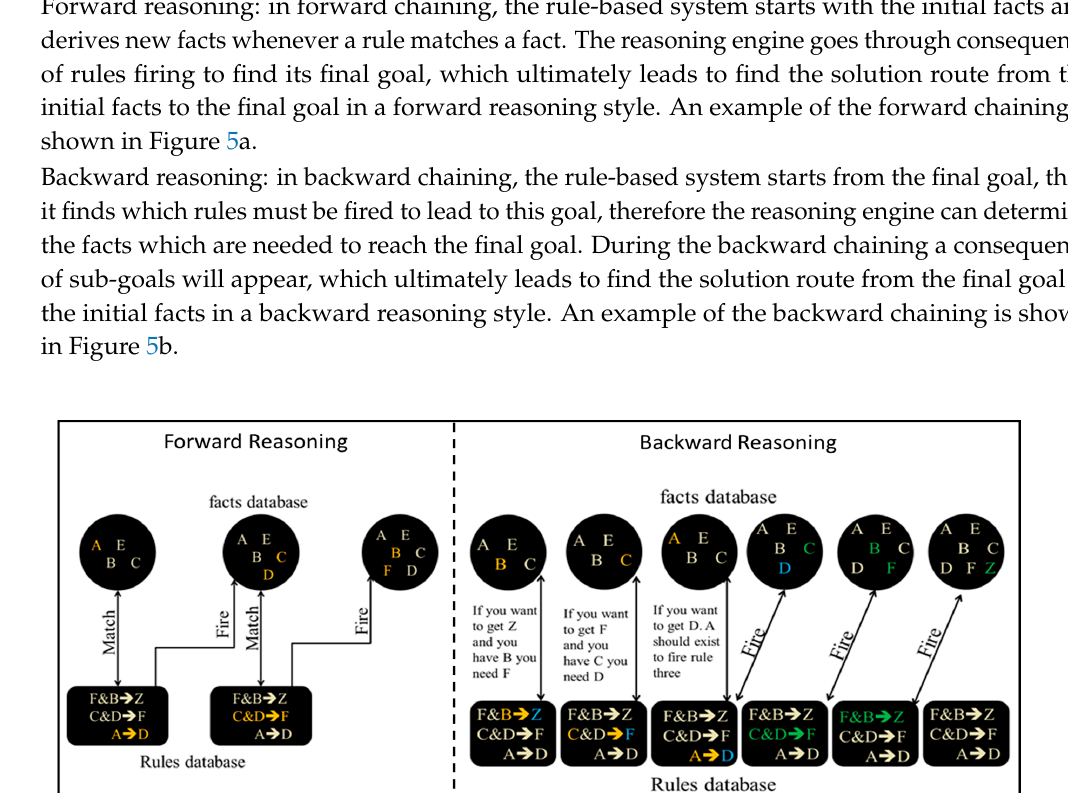
Figure 4. Rule-based System (a) Components and Operating Mechanism; (b) An Example.